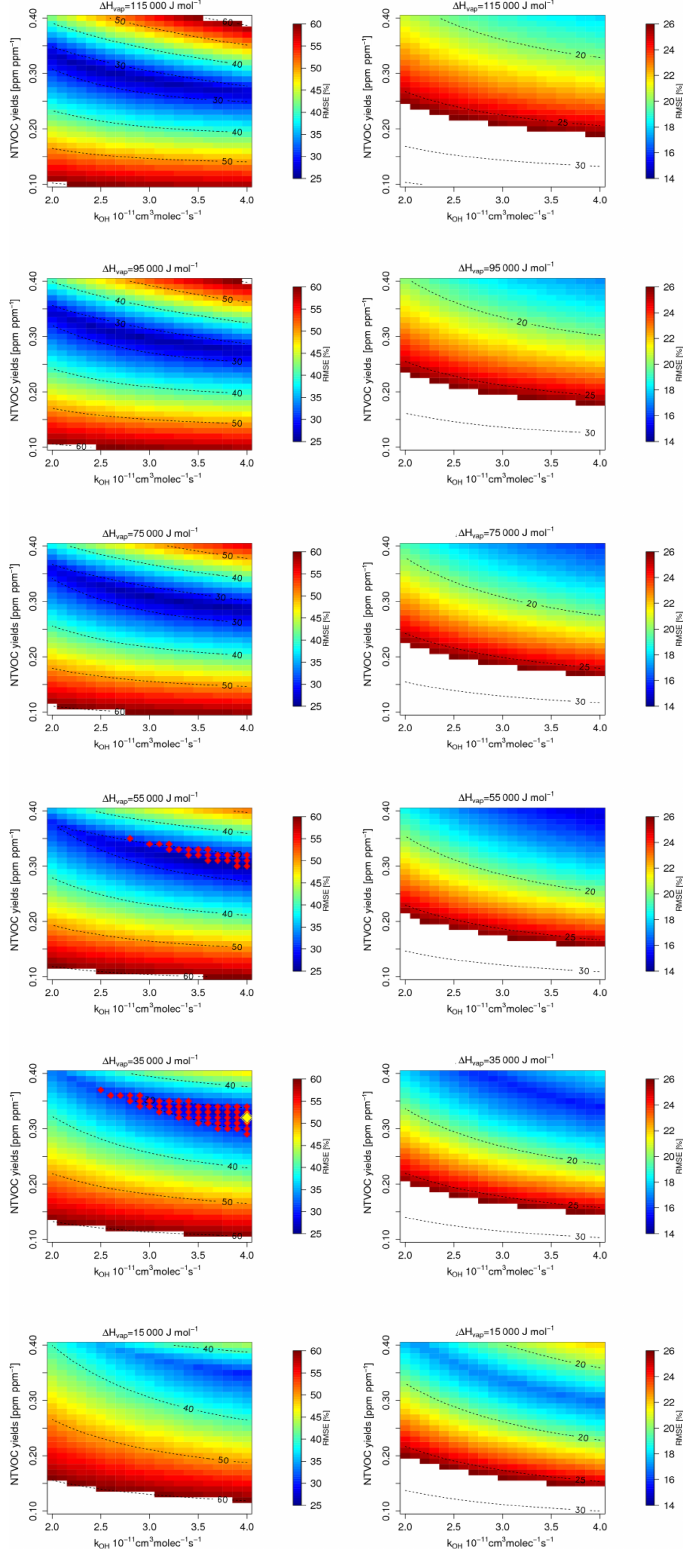
Figure 3. Total error on the OA mass (left side) and on the O:C ratio (right side). White regions have an error larger than 60% for the OA mass and 26% for the O:C ratio. The number of simulations per experiment is 3906. The red diamonds indicate the likelihood-ratio test results for solutions within 10% error from the best one (yellow